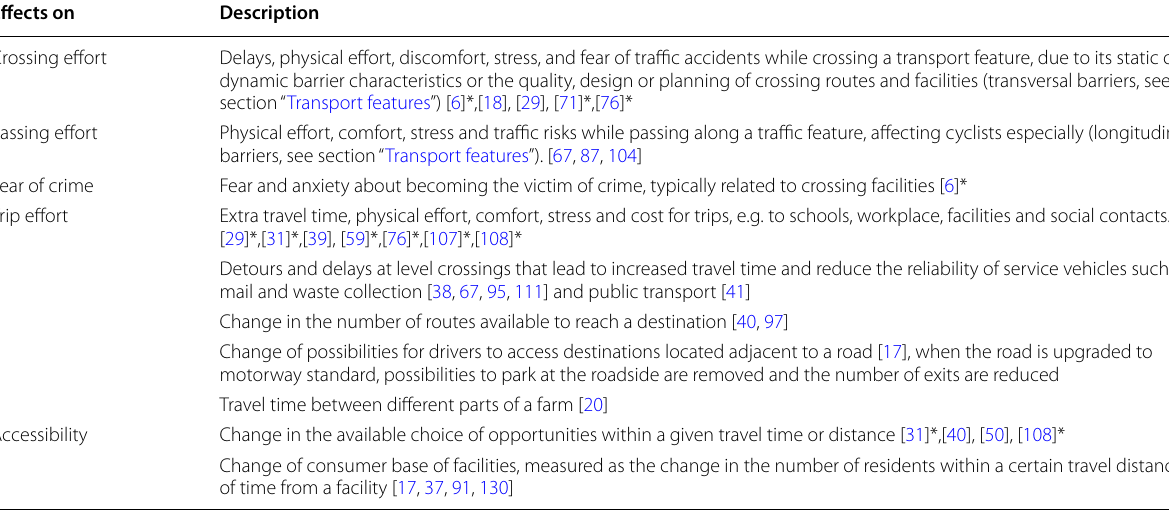
Table 6 Direct barrier effects of traffic and transport infrastructure